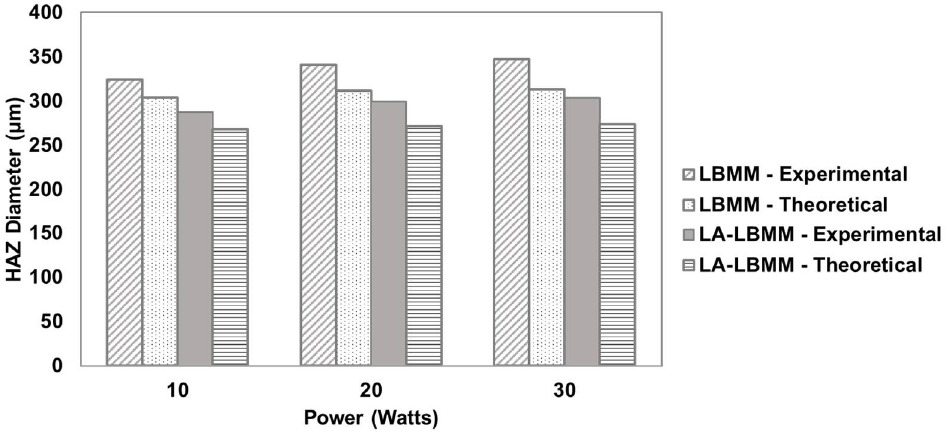
Figure 12. Comparison between HAZ diameters of experimental and analytical model predictions for the LBMM and LA-LBMM processes.